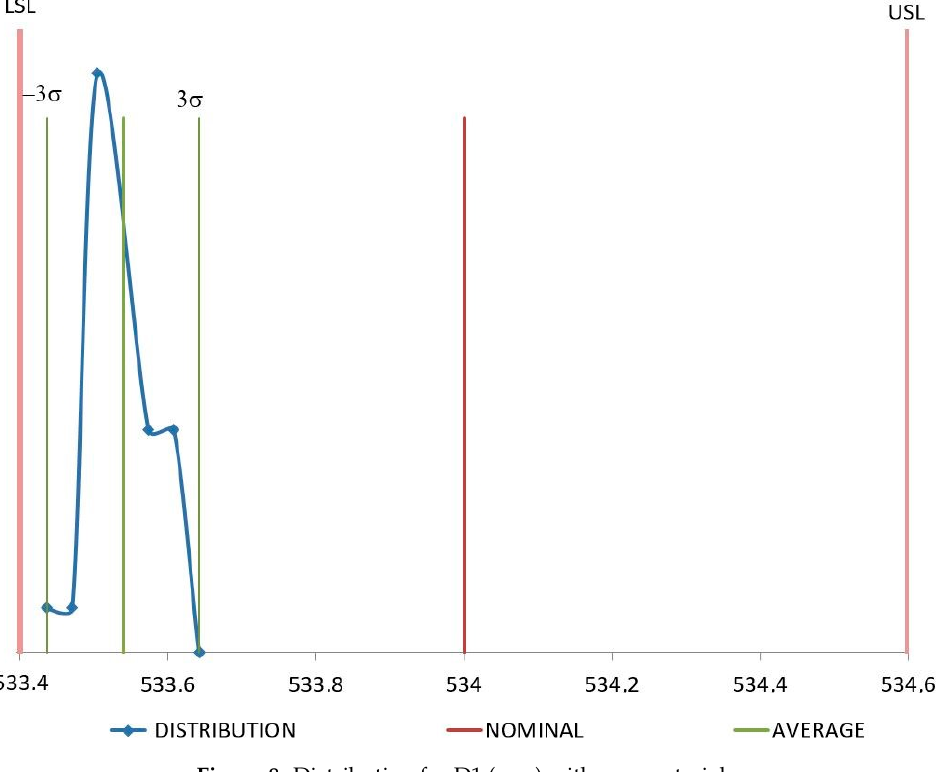
Figure 8. Distribution for D1 (mm) with raw material.